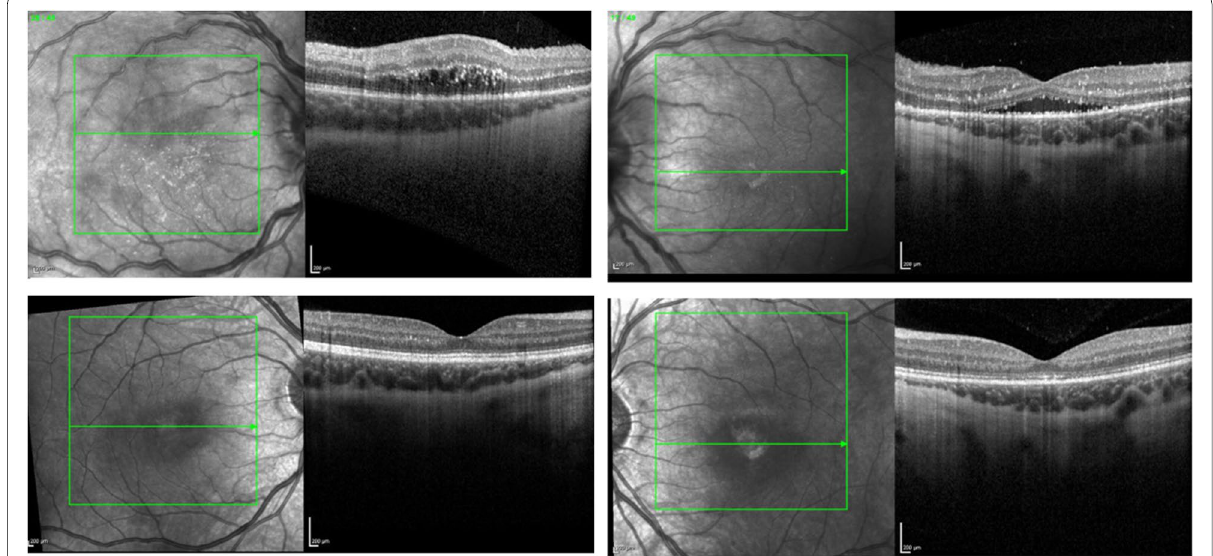
Fig. 3 A , B Spectrum domain optical coherence tomography-macula (SD OCT-m) of the right and left eyes, taken a month after presentation demonstrates macular edema with intraretinal hyperreflective foci and disruption of the external limiting membrane, IS/OS junction and RPE of the right eye (3 A ) and intraretinal hyperreflective foci, subretinal fluid and hyperreflective foci at the level of the photoreceptors and RPE of the left eye (3 B ). C , D SD OCT-m of the right and left eyes taken at 4 month follow-up that demonstrates improved edema with few persistent intraretinal hyperreflective foci of the right eye (3C) and resolving subretinal fluid with improvement of the IS/OS junction in the left